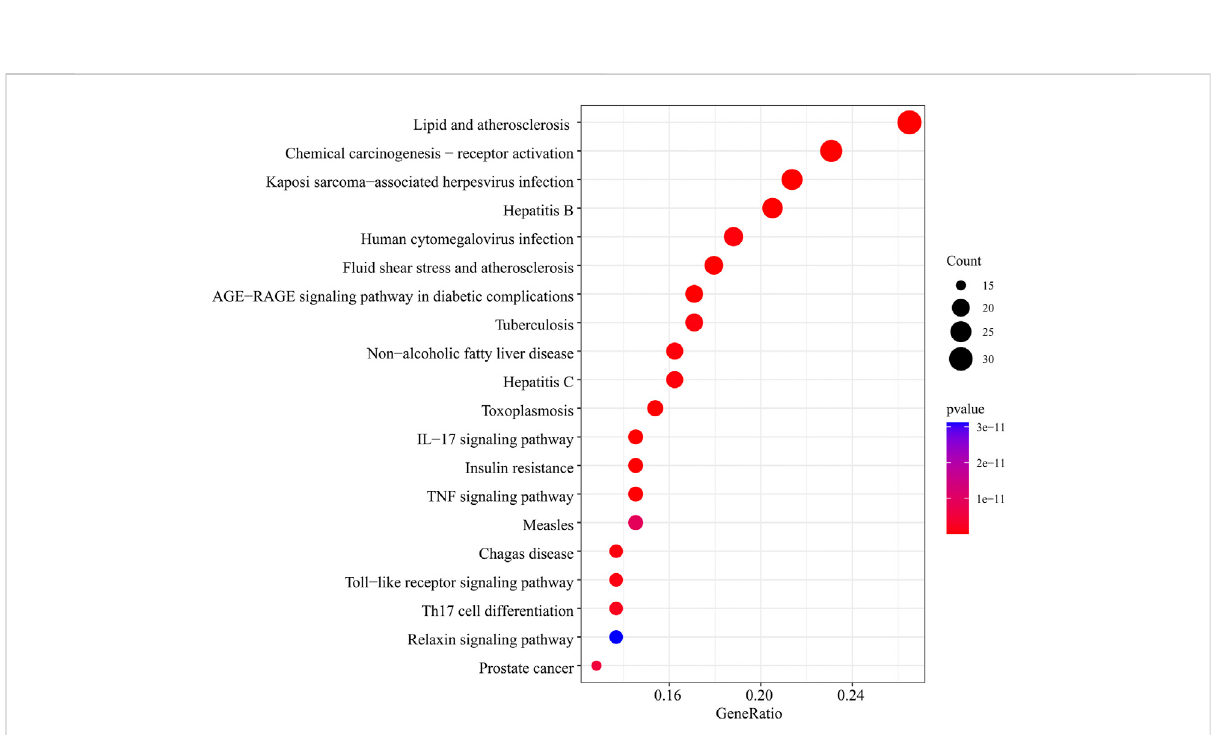
FIGURE 5 The top 20 pathways for the KEGG pathway are enriched from the common targets between LTD and DKD.